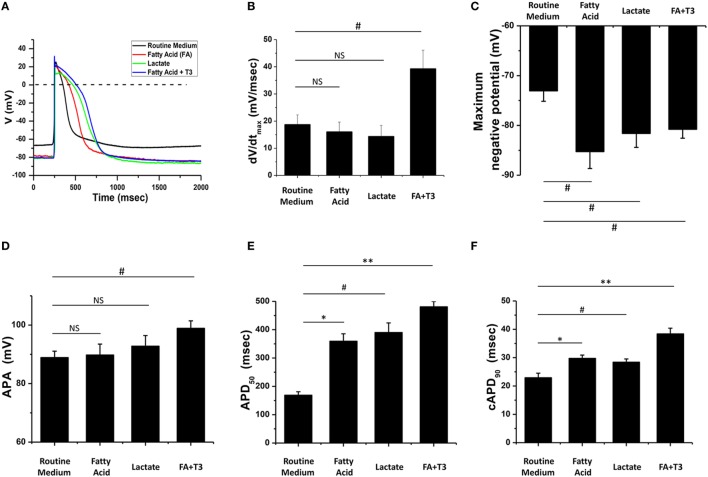
Fatty acid and T3-treated cardiomyocytes exhibited more mature action potential (AP) morphology. (A) Representative AP traces of cardiomyocytes cultured with metabolic selection medium and routine medium. (B–F) AP indices of dV/dtmax, the maximum negative potential, action potential amplitude (APA), AP duration at 50% of repolarization (APD50), and the corrected AP duration at 90% of repolarization (cAPD90) from cardiomyocytes cultured with metabolic selection medium and routine medium (routine medium, n = 20 cells; fatty acid, n = 18 cells; lactate, n = 17 cells; fatty acid + T3, n = 20 cells). Only the combination of fatty acid + T3 treatment significantly improved all indices. NS, no significant difference; #P < 0.05; *P < 0.01; **P < 0.001.